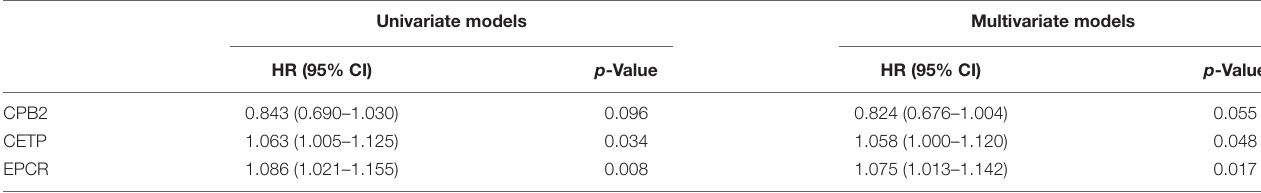
TABLE 2 | Relation of target proteins and MACEs in univariate and multivariate survival analysis.